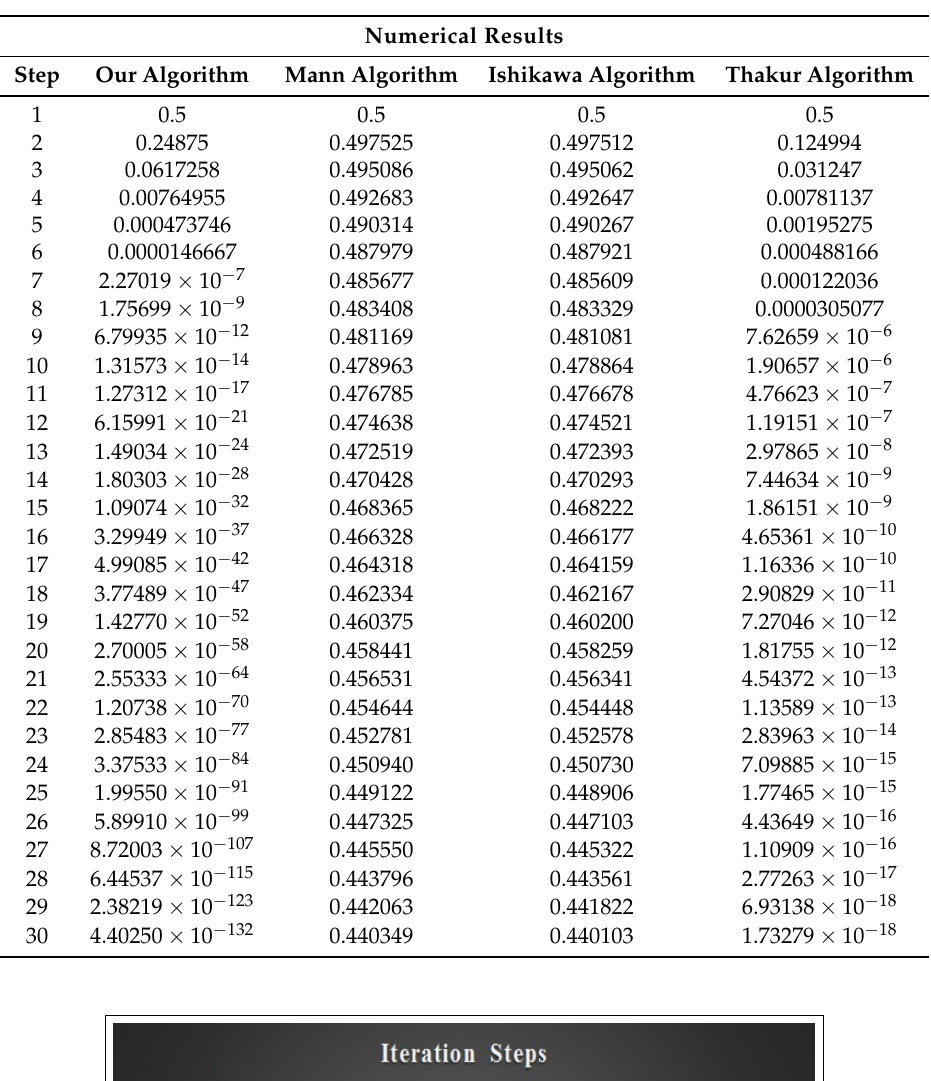
1 for 30 steps. 2